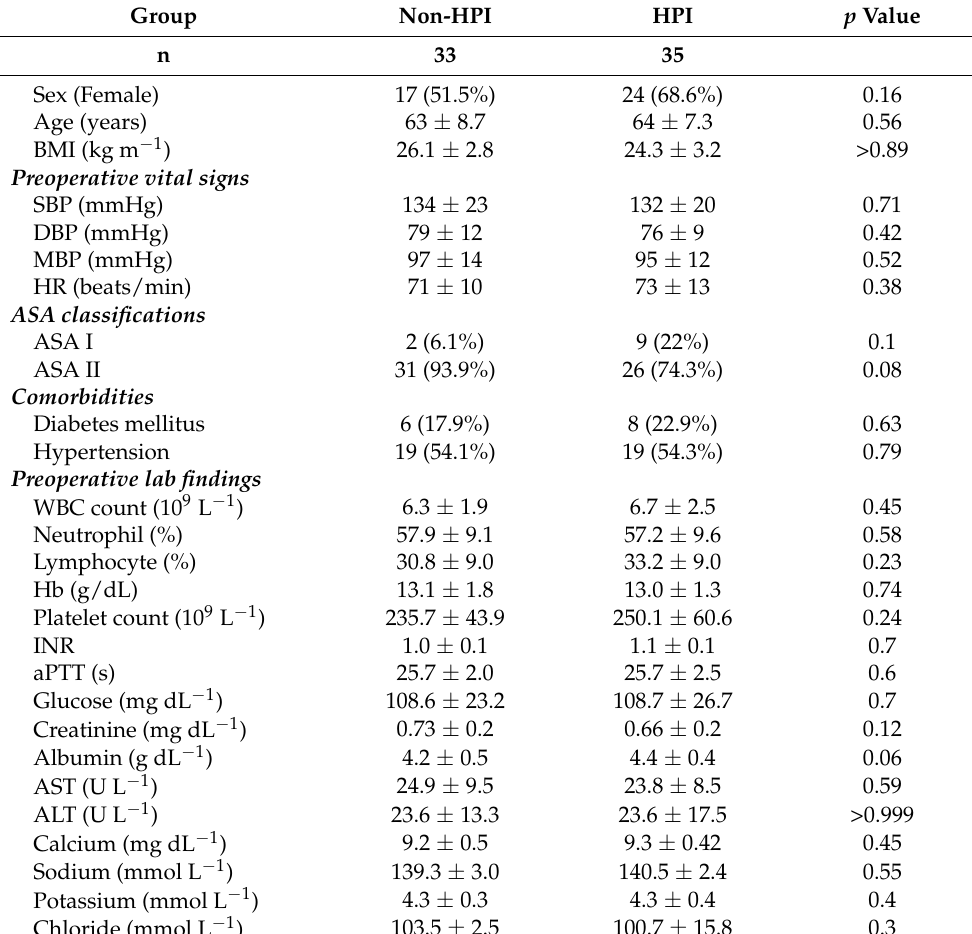
Table 1. Demographic findings.